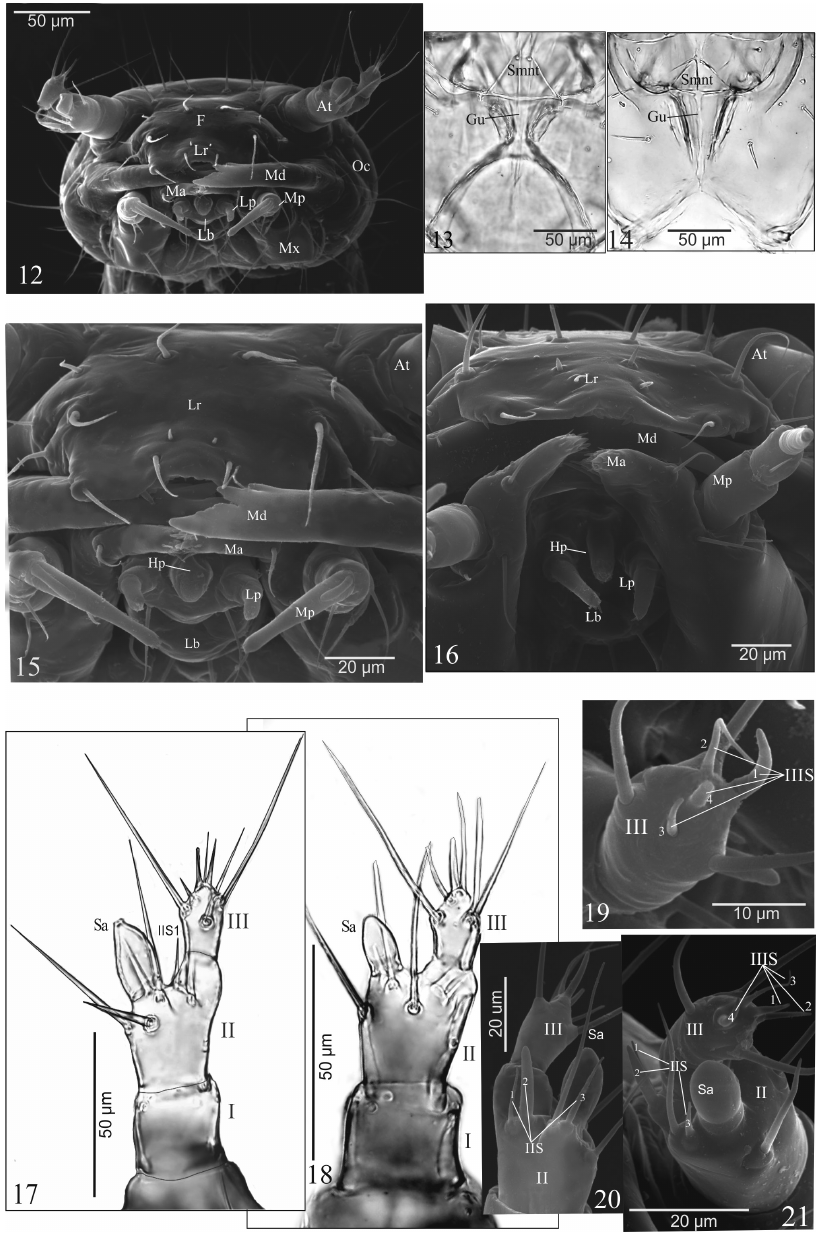
in fronatl aspect 13, 14 gular region 15, 16 functional position of mouthparts in frontal aspect 17–21 right antenna in dorsal aspect ( 17, 18 ), entire article III in anterior ( 19 ) and in ventral ( 20 ) aspect, entire article II and III in anterior aspect ( 21 ). Abbreviations: I-III, antennal articles; IIS, IIIS, solenidia of anten- nal article II or III; At, antenna; F, frons; Gu, gula; Hp, hypopharynx; Lp, labial palp; Lr, labrum; Ma, mala; Md, mandible; Mx, maxilla; Pm, maxillary palp; Oc, ocellus; Sa, sensory appendage; Smnt,